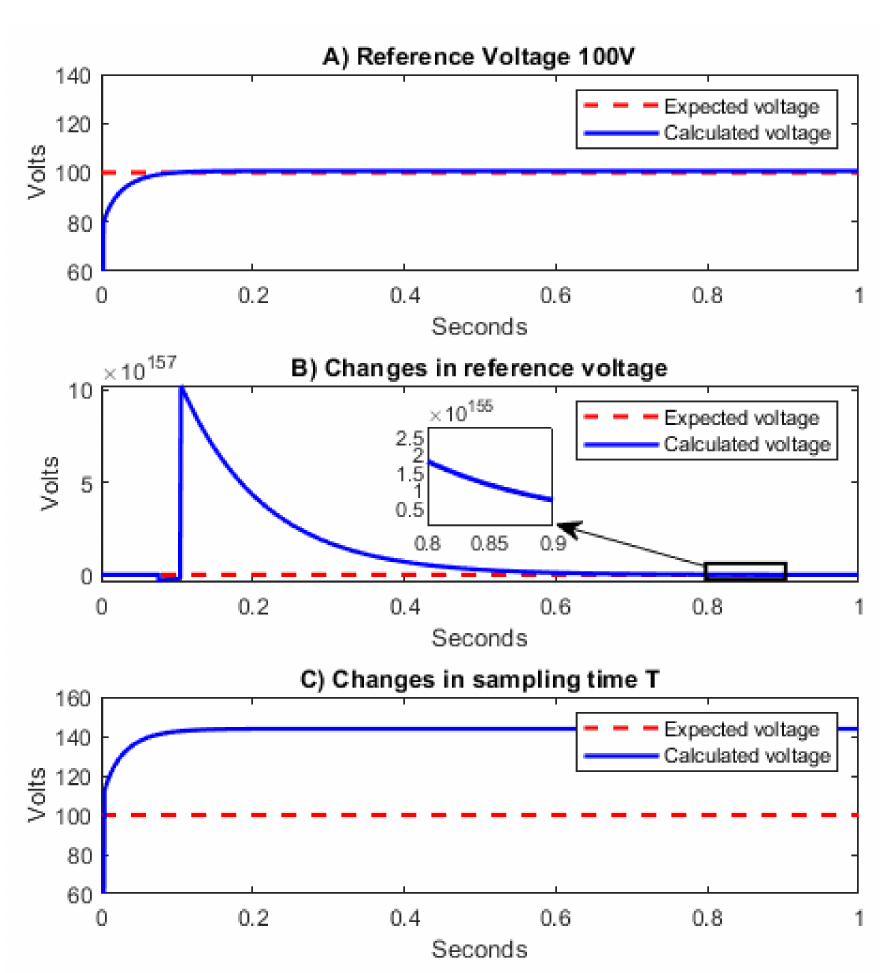
Figure 2. ( A ) Implementation of inverse optimal control, ( B ) change in reference voltage, ( C ) change in sampling time T